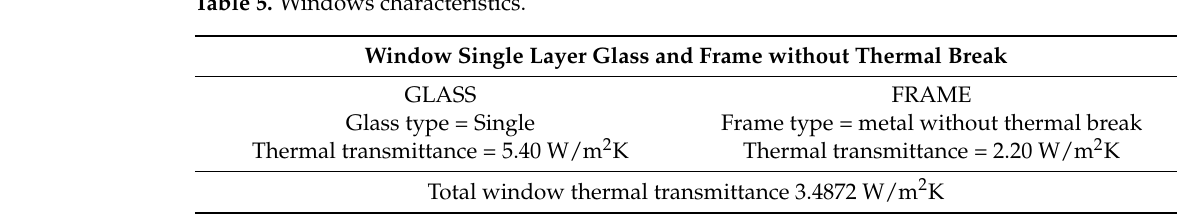
Table 5. Windows characteristics.